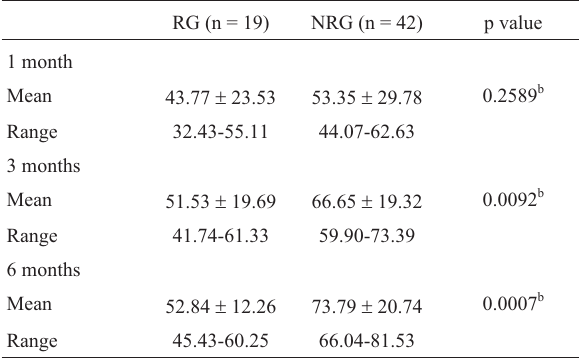
Table 2 - Kidney function by creatinine clearance (mL/min) a of the allograft kidney